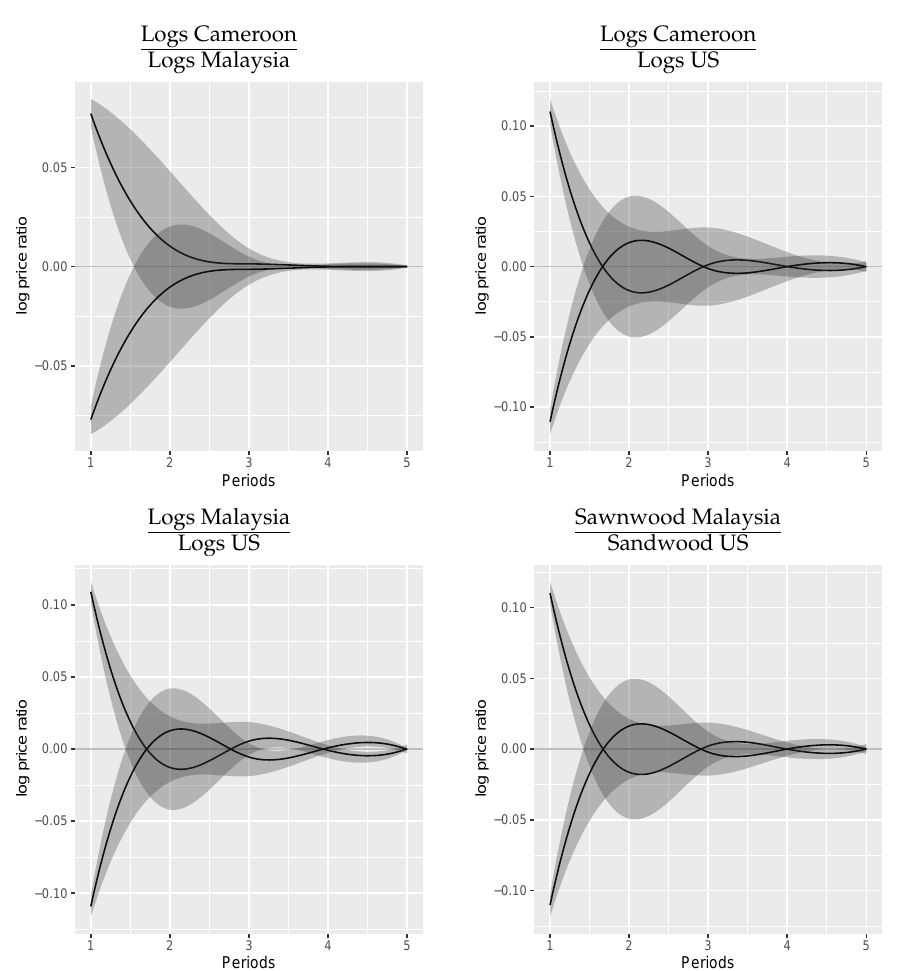
Figure 3. Impulse Response Functions for a One Standard Deviation Shock to the Monthly Forest Products Price Ratios. Each graph illustrates the 95% confidence interval of an impulse of ± 1 standard deviation of the estimation error, based on 500 bootstrap